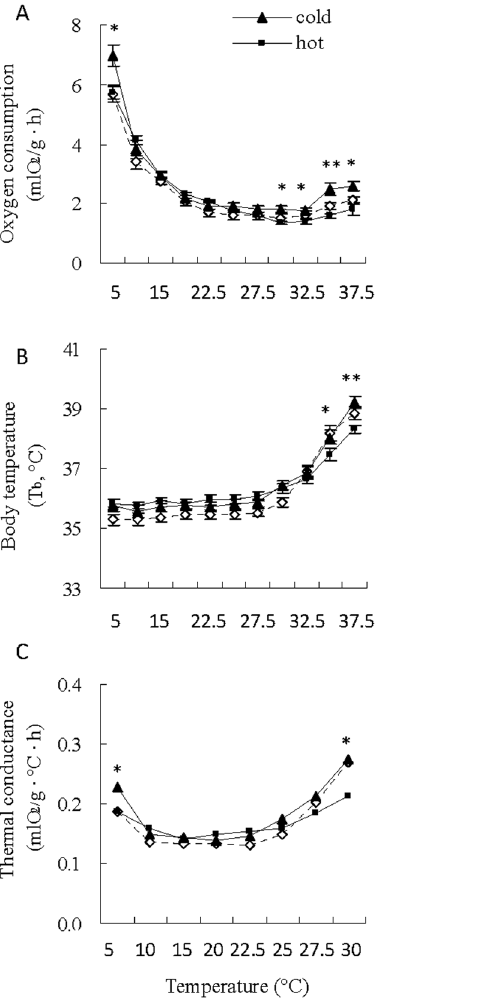
Figure 1. Oxygen consumption (A), body temperature (B) and thermal conductance (C) over a range of temperature between 5 and 37.5 6 C in striped hamsters acclimated to warm (23 6 C), cold (5 6 C) and hot (31 6 C) conditions. *, significant difference between the three groups ( P , 0.05), **, P , 0.01. Data are means 6